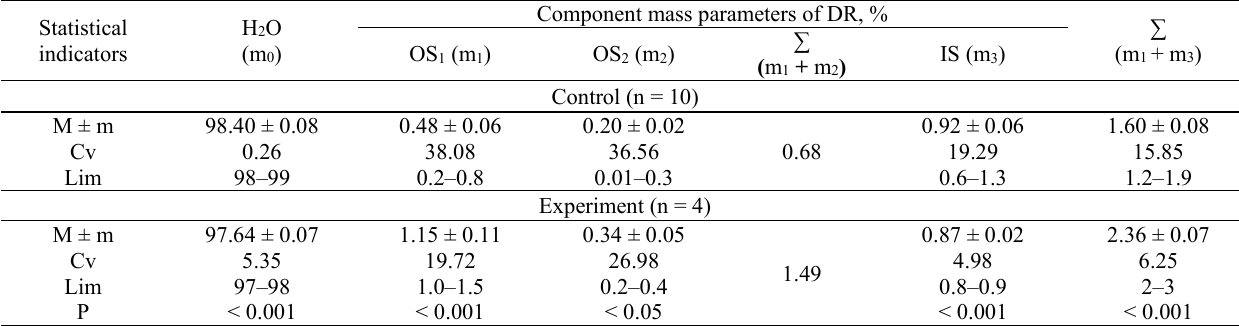
Relative indicators of samples mass of dry residue of uterine and vaginal mucus Statistical Н 2 О indicators (m 0